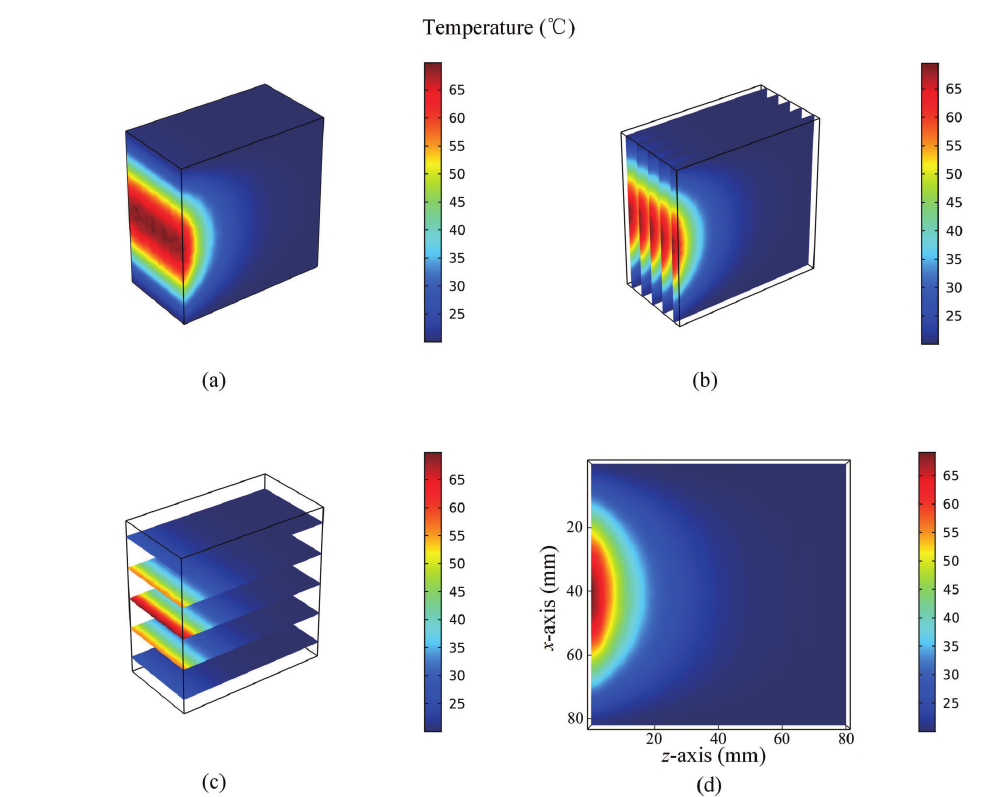
Figure 4. Finite element method (FEM) calculation results. ( a ) Temperature distribution of the mate- rial in a rectangular waveguide. ( b ) Temperature distribution in the vertical sections. ( c ) Temperature distribution in the horizontal section. ( d ) Temperature distribution in the central vertical